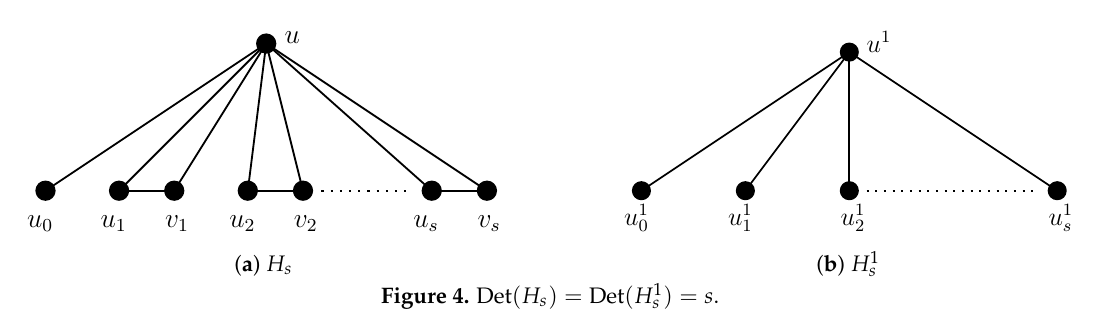
Figure 4. Det ( H s ) = Det ( H 1 s ) = s